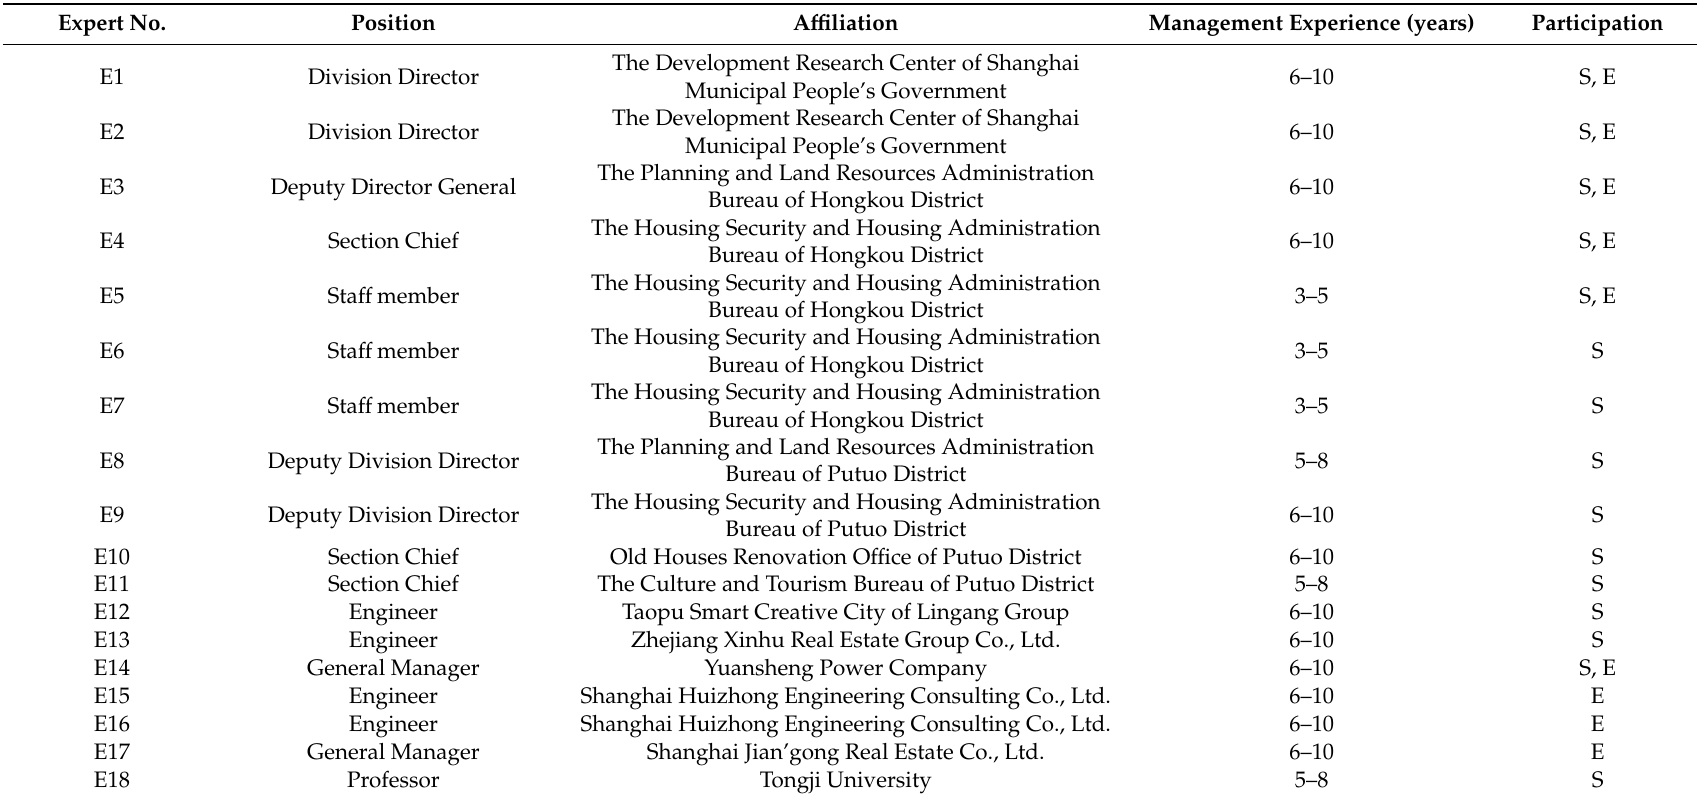
Table 2. Expert profiles for the